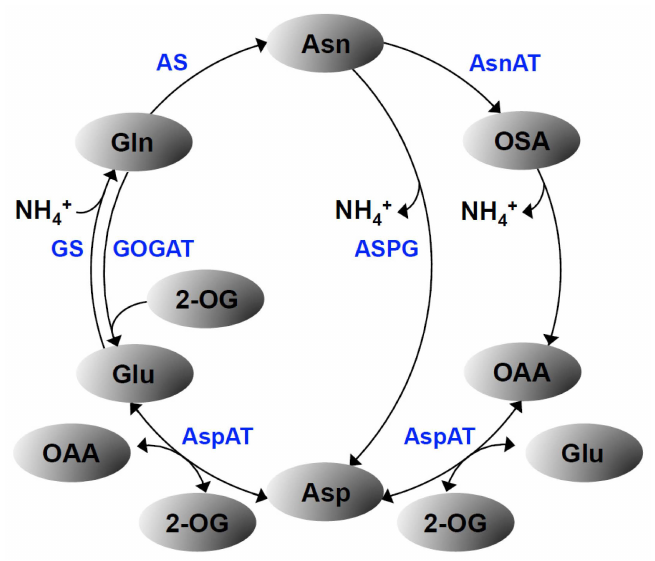
Figure 4. Schematic presentation of asparagine metabolism. AS: asparagine synthetase (EC 6.3.5.4), Asn: asparagine, AsnAT: asparagine aminotransferase (EC 2.6.1.45), Asp: aspartate, AspAT: aspartate aminotransferase (EC 2.6.1.1), ASPG: asparaginase (EC 3.5.1.1), Gln: glutamine, Glu: glutamate, GOGAT: glutamate synthase (Ferredoxin-GOGAT, EC 1.4.7.1 and NADH-GOGAT, EC 1.4.1.14),